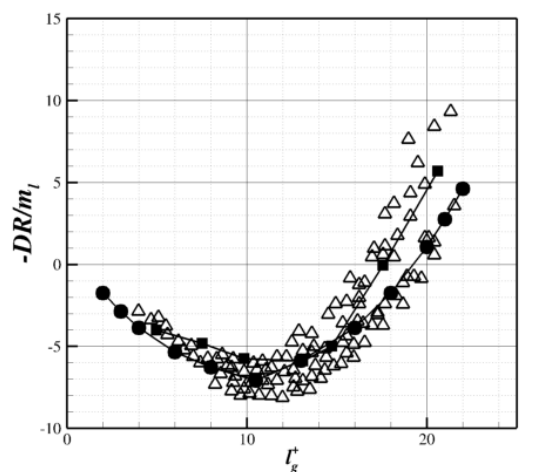
Figure 1. Computed drag reduction vs. l + g . – (cid:4) –: DNS by [33], – • –: Equation (6), (cid:52) : experiment [7].